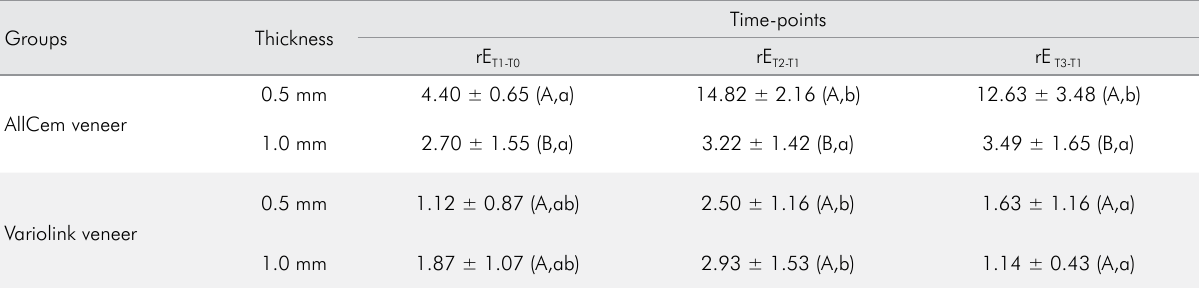
Table 1. CIELab (rE ) color measurement observed in each experimental set (mean ± STD). ab Groups